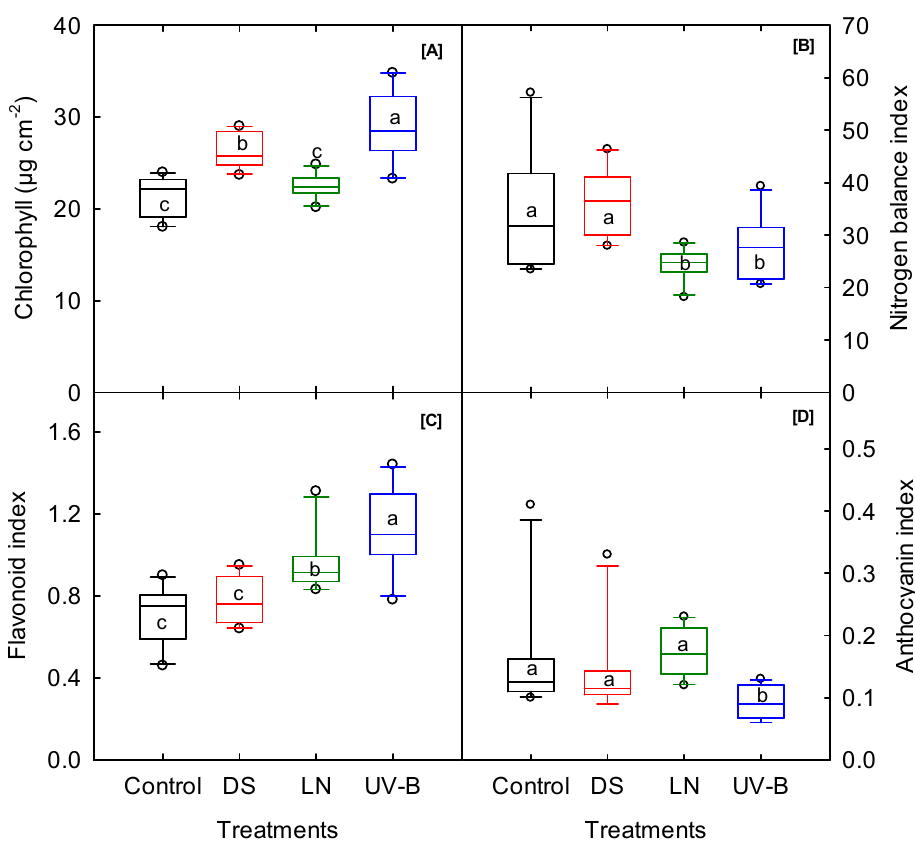
Figure 2. Drought (DS), low nitrogen (LN), and ultraviolet-B (UV-B) effect on ( A ) chlorophyll concentration, ( B ) nitrogen balance index, ( C ) flavonoid index, and ( D ) anthocyanin index of 10 sweet potato cultivars measured at 20 days after planting. The middle line indicates the median, and the box shows the range of the 25th to 75th percentiles of the total data. The different alphabetic letters (a, b, and c) labeled within the box represent the significant differences between treatments (Duncan Multiple Range Test, p < 0.05), and the outer dots are outliers.